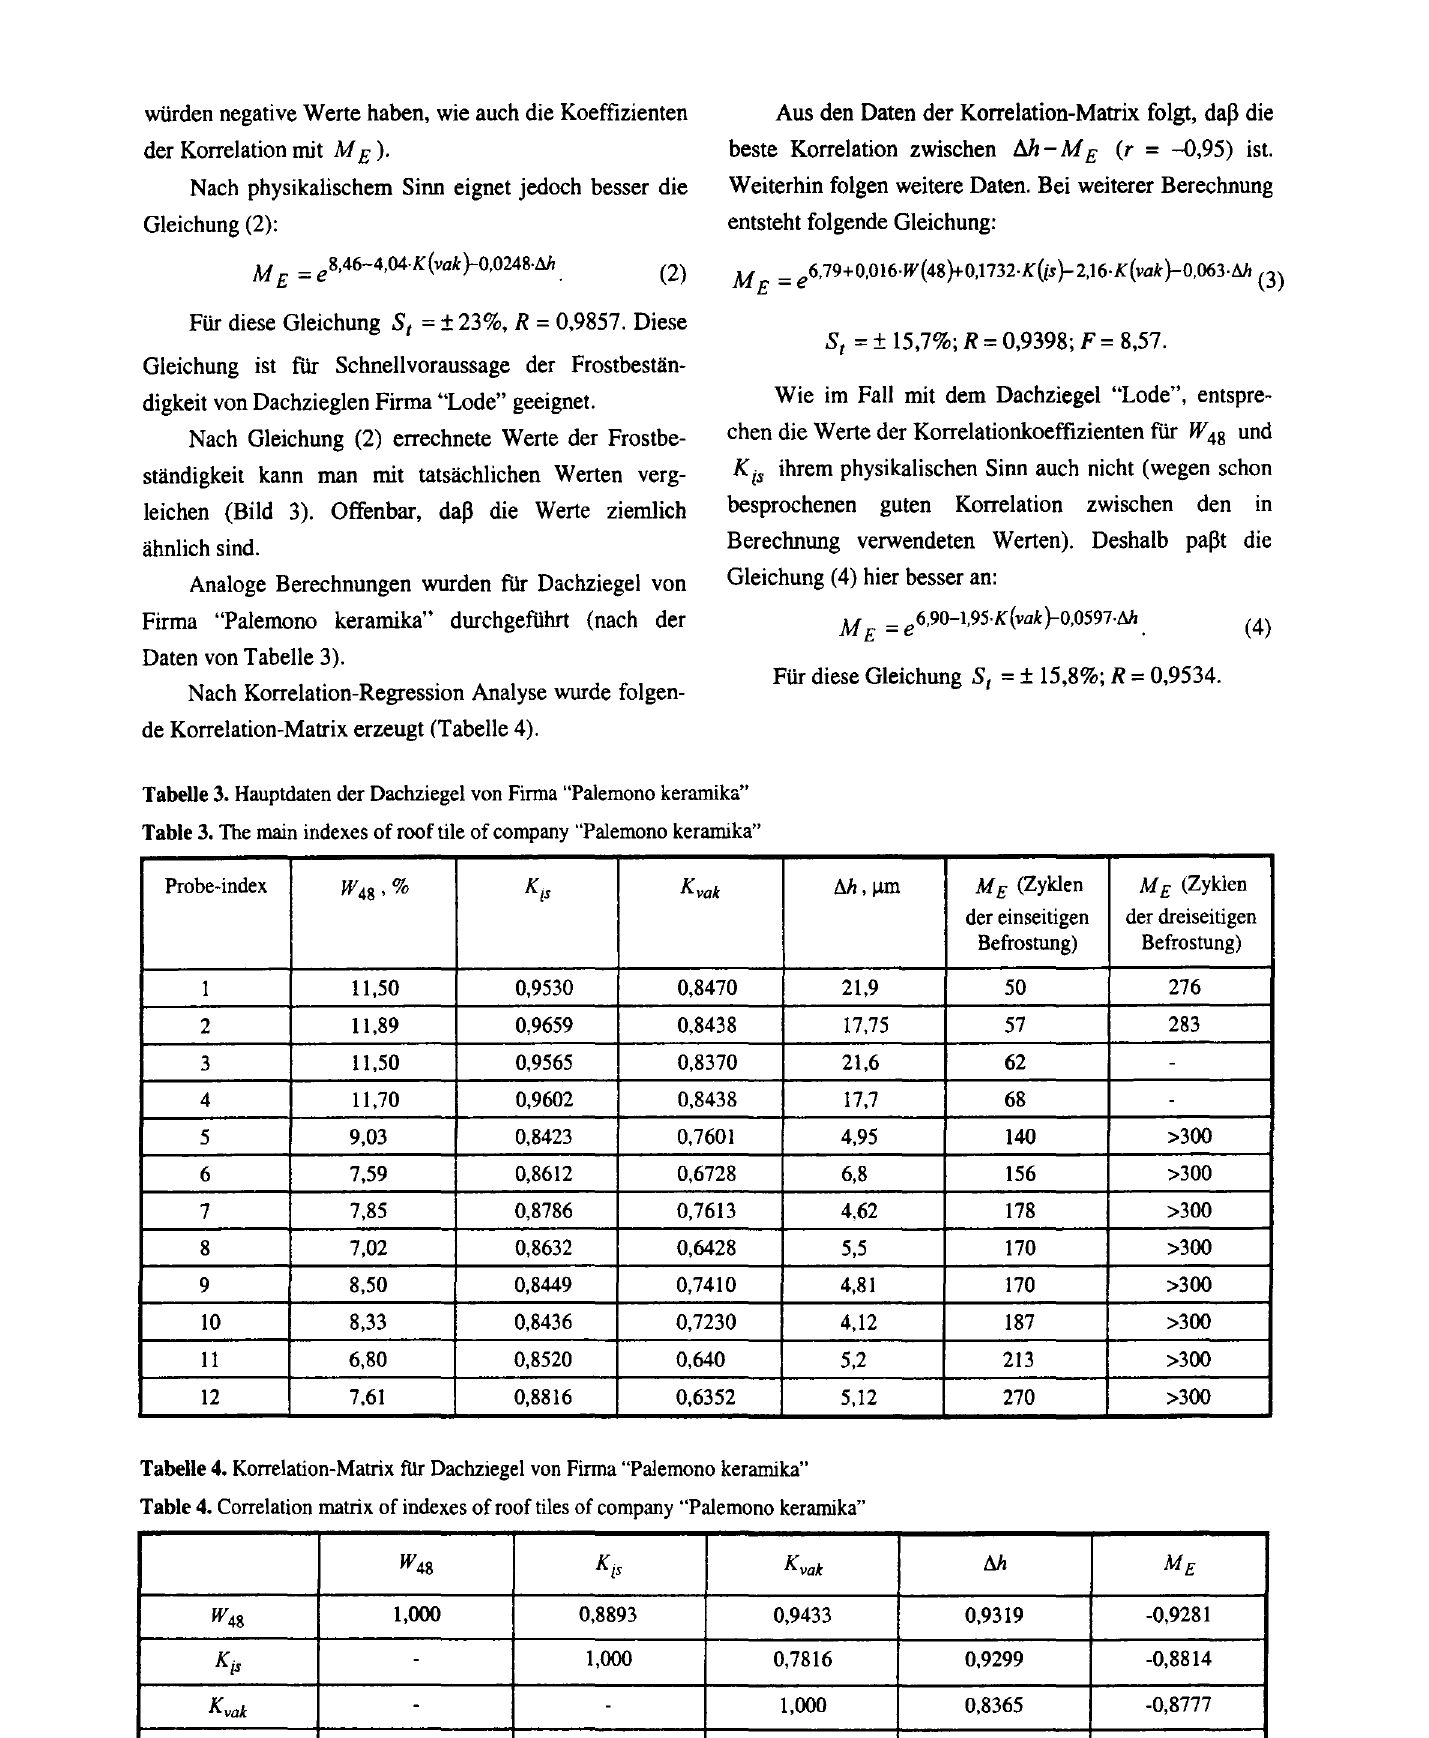
Table 3. The main indexes of roof tile of company "Palemono kerarnika"